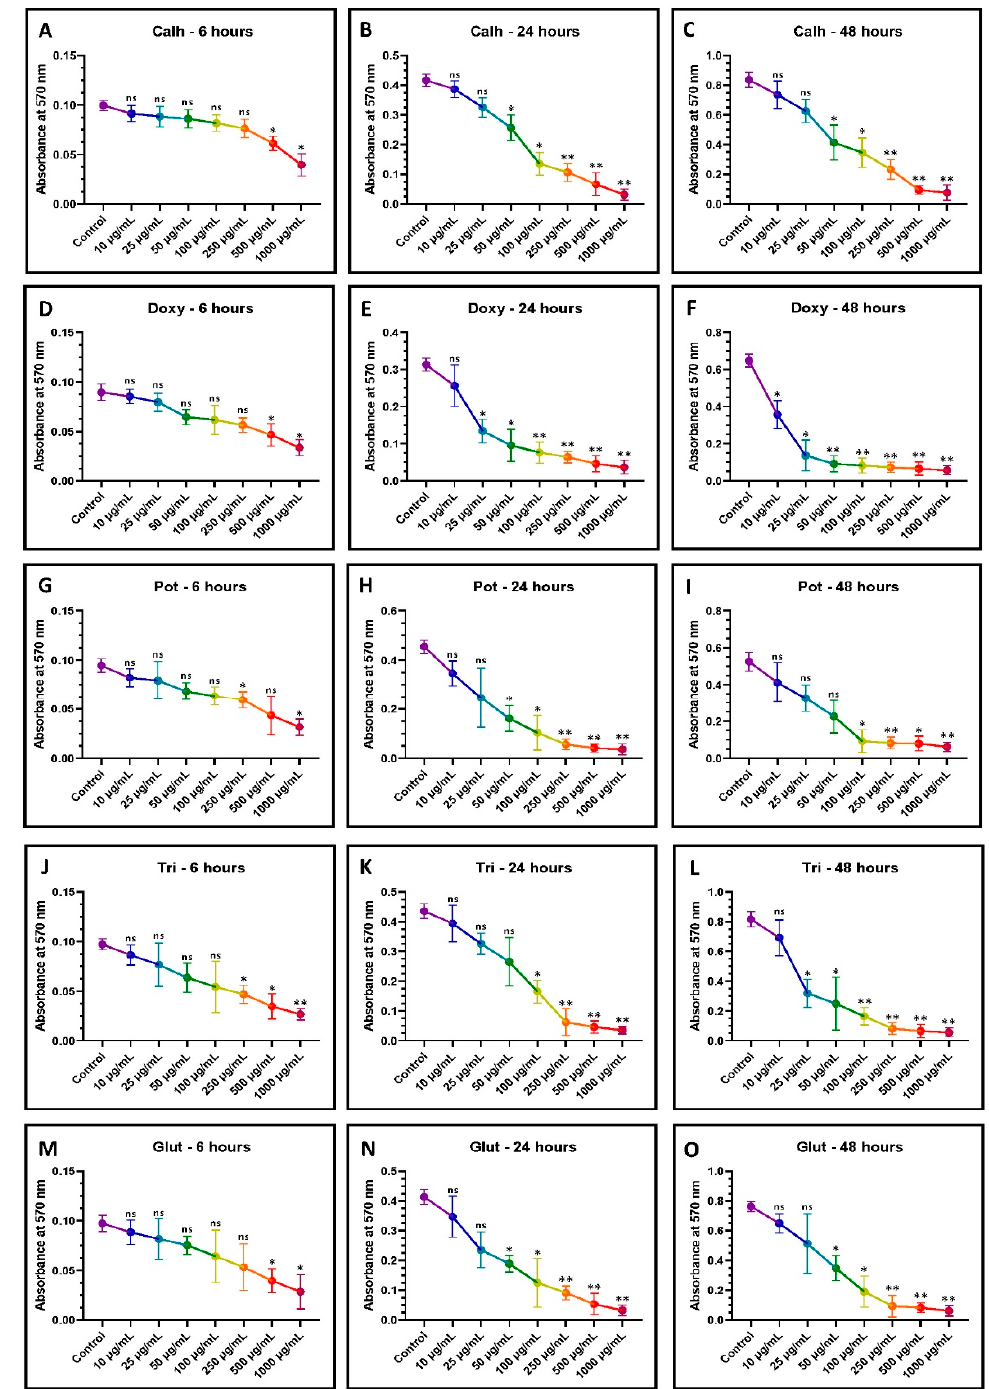
Figure 2. MTT assay for the assessment of cytotoxicity. ( A – O ) DPSCs were treated with various concentrations of individual drugs (0 µg/mL, 10 µg/mL, 25 µg/mL, 50 µg/mL, 100 µg/mL, 250 µg/mL, 50 µg/mL, and 1000 µg/mL) for 6, 24, and 72 h, and a comparative analysis was done to check the cytotoxicity of the drugs to DPSCs. ns is not significant; * p < 0.05 and ** p < 0.01.